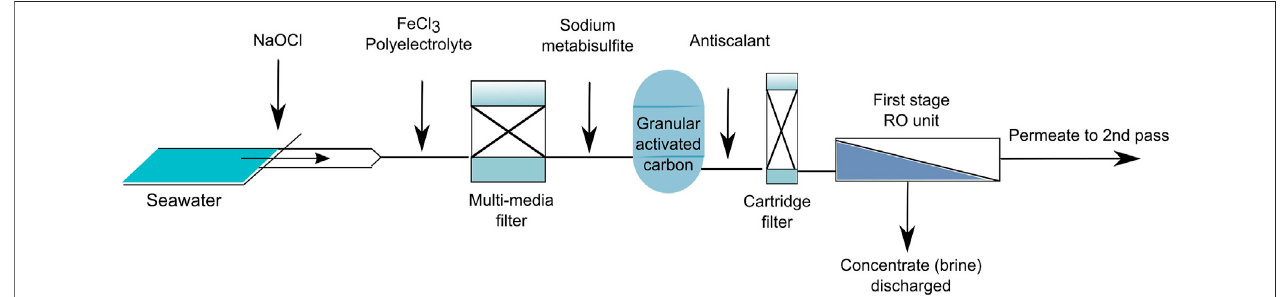
FIGURE 2 | The layout of the full-scale desalination plant showing the location of dosage for different